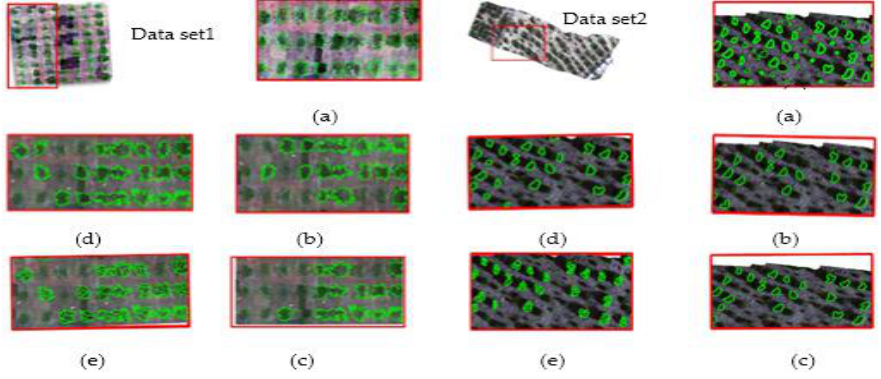
Figure 3. Result of tree crown extraction. (a) The proposed method, (b)Local Maxima, (c)Image Binarization, (d)Valley Following, (e)Watershed